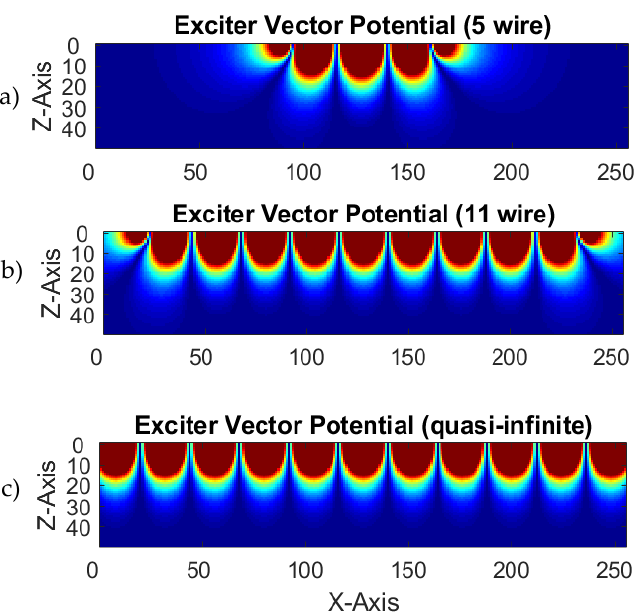
Figure A1. Calculated vector potential 𝐴 𝑦 of an undulator, sign suppressed. The x-coordinate extends in the horizontal direction and the z-coordinate in the vertical direction; ( a ) 5-wire undulator; ( b ) 11-wire undulator; ( c ) an undulator with 19 wires would behave as an almost infinite undulator with respect to the dimensions of the scanner and would virtually match Equation (2.2).